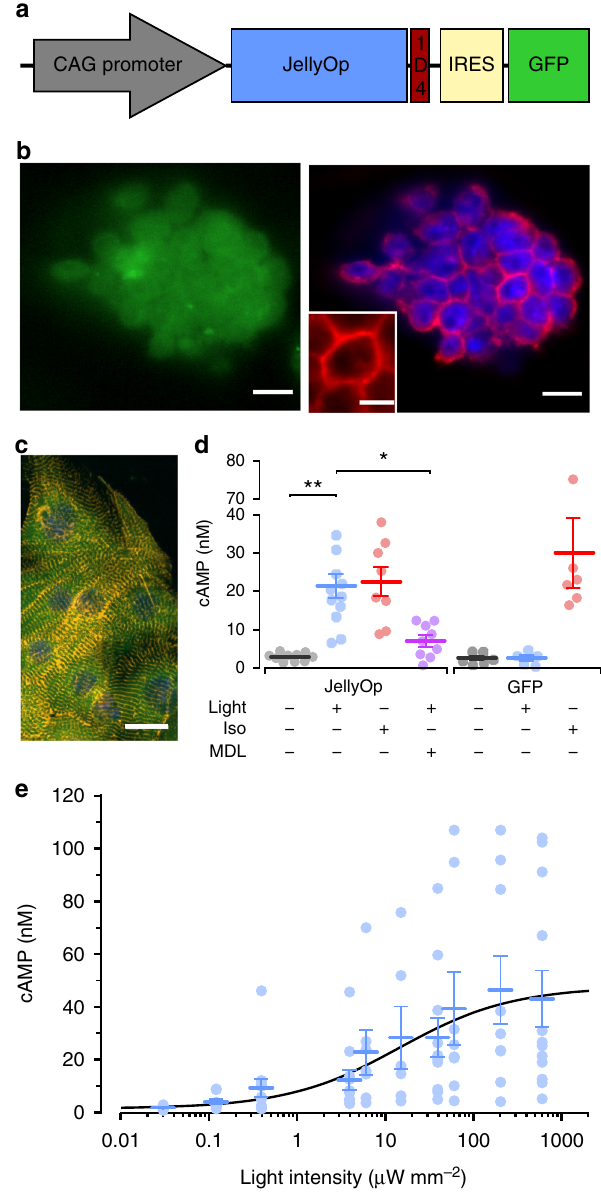
Fig. 1 Generation of JellyOp expressing mouse ESCs and light-induced cAMP production in cardiomyocytes. a Plasmid for expression of JellyOp in fusion with the 1D4 rhodopsin epitope and with an internal ribosome entry site (IRES) for co-expression of the green fl uorescence protein (GFP) under control of the chicken β -actin promoter (CAG). b Immunostaining of a transgenic ESC colony expressing GFP (green) and JellyOp (red: 1D4 rhodopsin epitope staining) (nuclear staining in blue, bars: 10 μ m; insert: 5 µ m). c GFP positive (green) cardiomyocytes indicated by α -actinin (yellow) staining (nuclear staining in blue, bar: 20 µ m). d cAMP